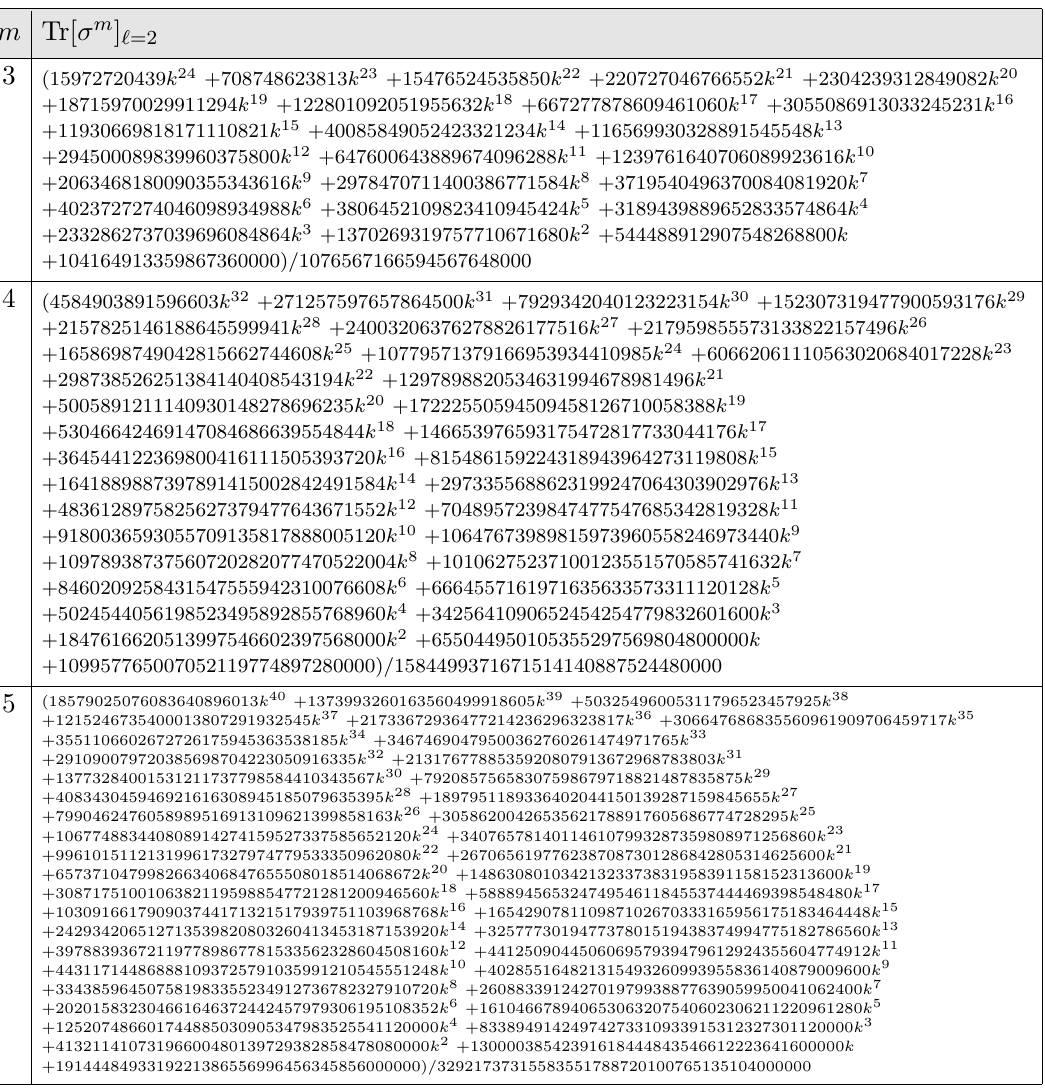
Table 8. The values of Tr [ σ m ] as a function of k for T 4 , 12 torus link. The subscript ‘ indicates that the polynomial is valid for k ≡ ‘ ( mod 3)